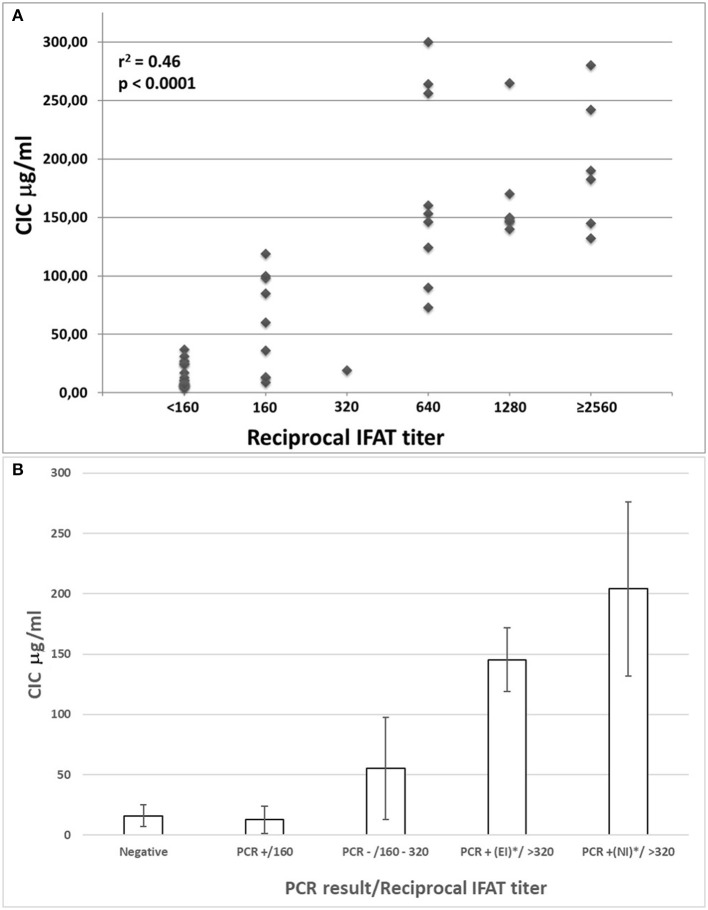
(A) Correlation between IFAT titers and CICs levels in sera from 52 non-infected or Leishmania infantum-infected beagles; (B) CICs serum levels (median ± SD) in five groups of beagles classified by negative condition or by Leishmania infantum infection characterized by different serological and parasitological parameters. EI, experimental infection; NI, natural infection.